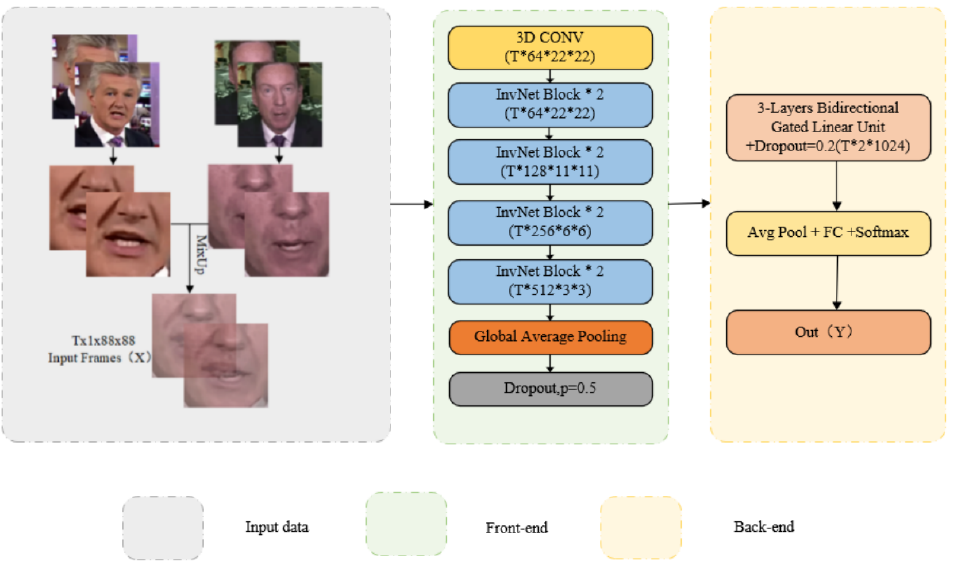
Figure 5. The optimized lip language recognition